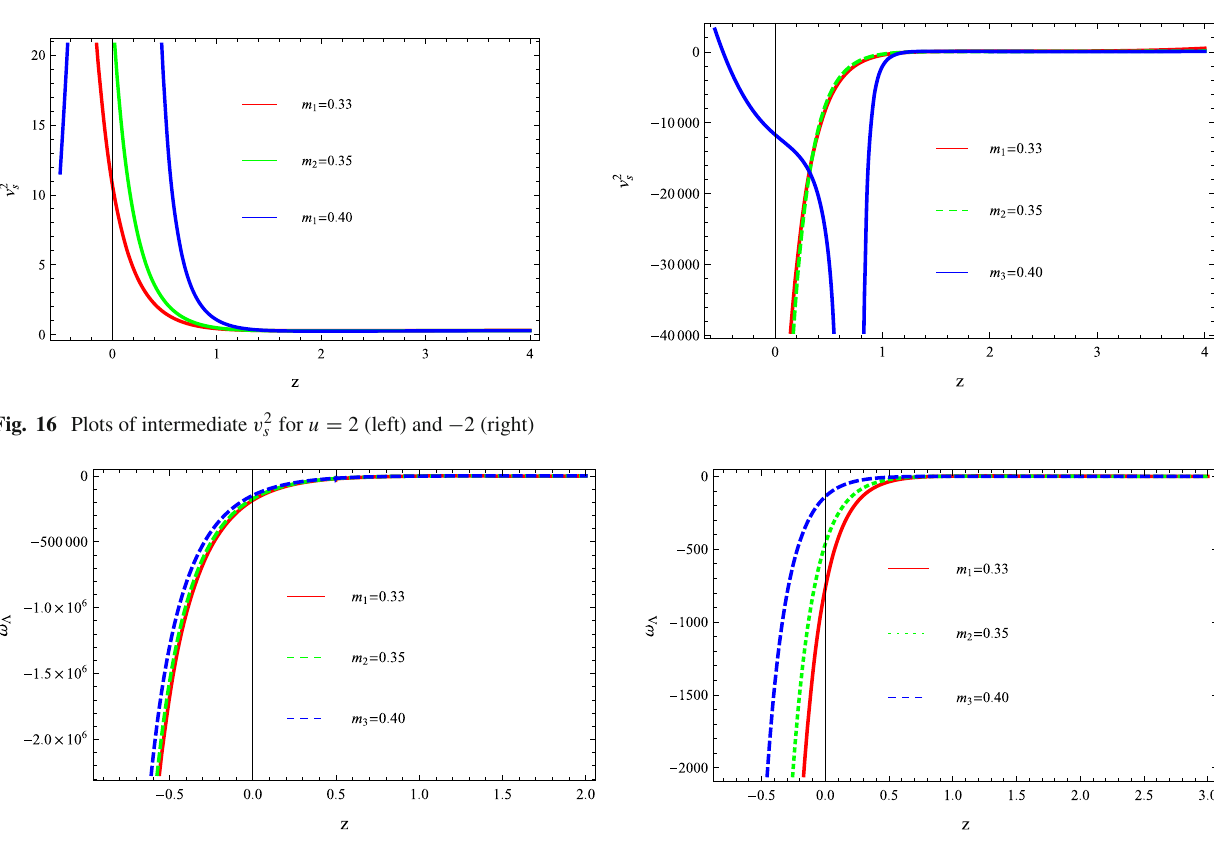
Fig. 17 Plots of intermediate EoS parameter ω (cid:3) for u = 2 (left) and − 2 (right). Also, H 2 = 2 . 7 (red), H 2 = 2 . 75 (green) and H 2 = 2 . 8 (blue)